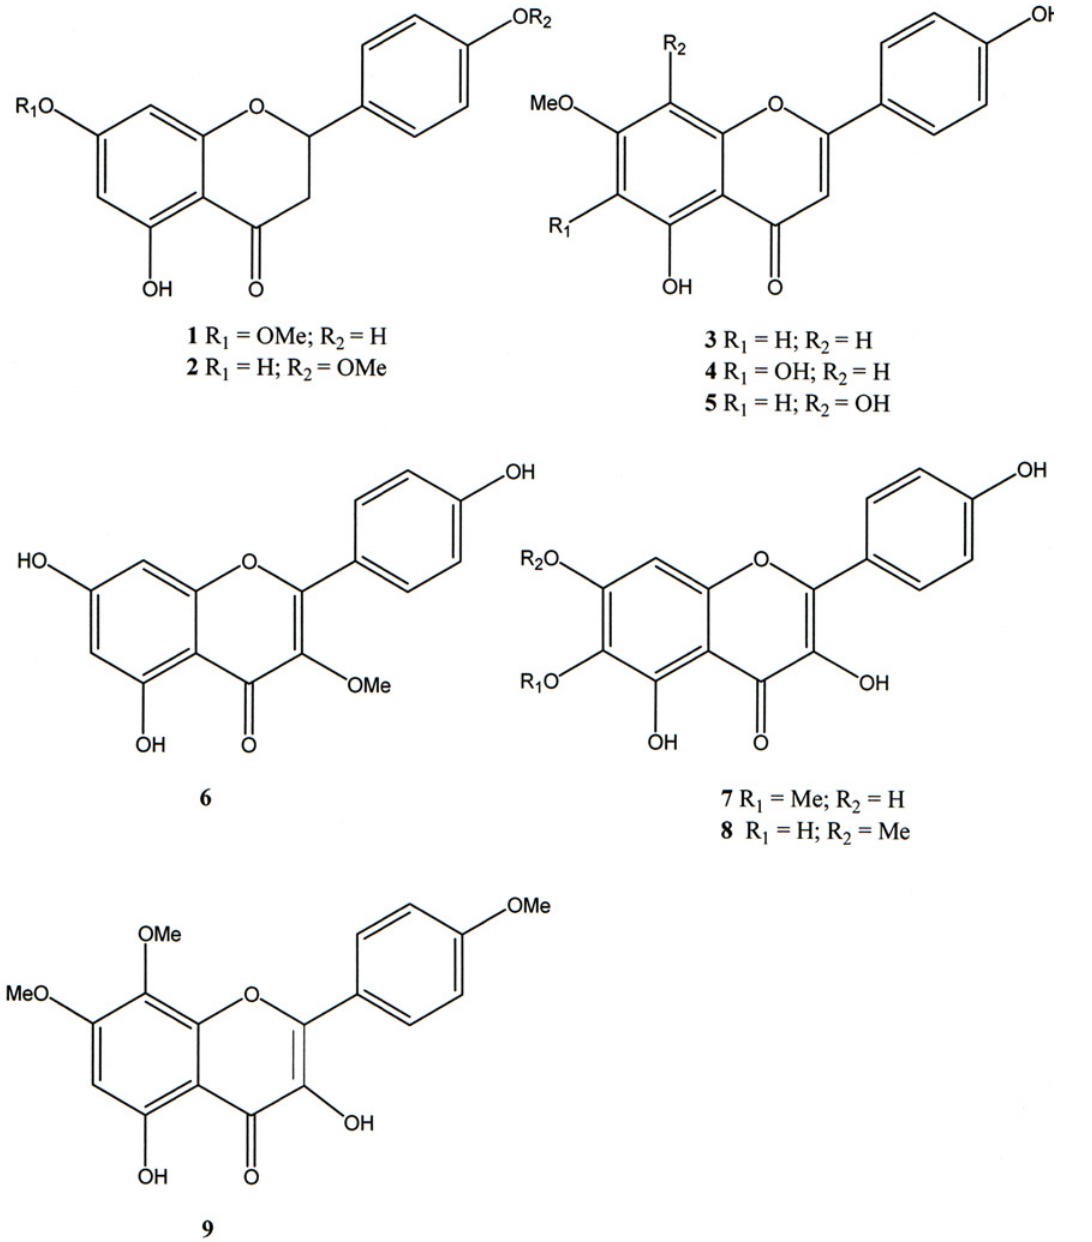
Fig 1. Flavonoids from Mimosa tenuiflora